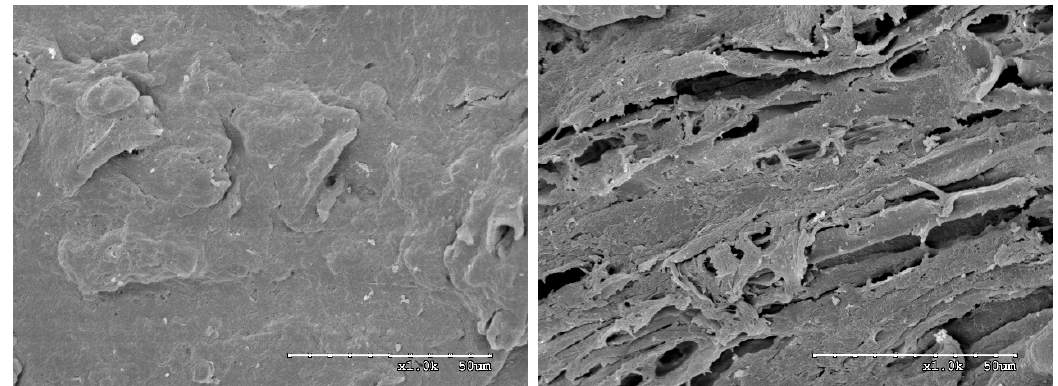
Figure 6. SEM micrographs of the raw wheat straw .